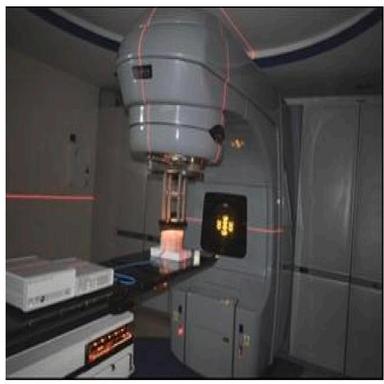
Experimental setup used to measure de depth dose as the bolus thickens is increased. Here, the A10 applicator is used.